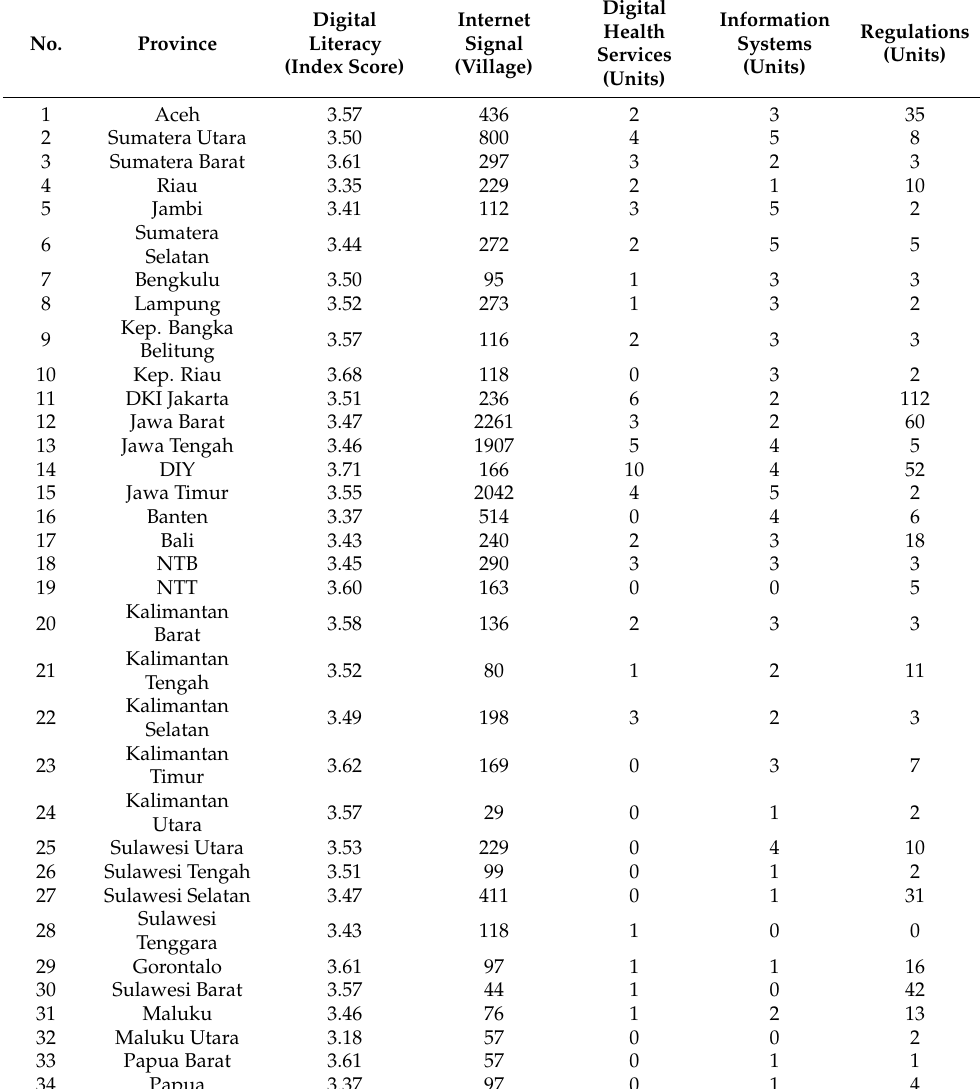
Table 2. Implementation of Digital Health Services Indonesia in